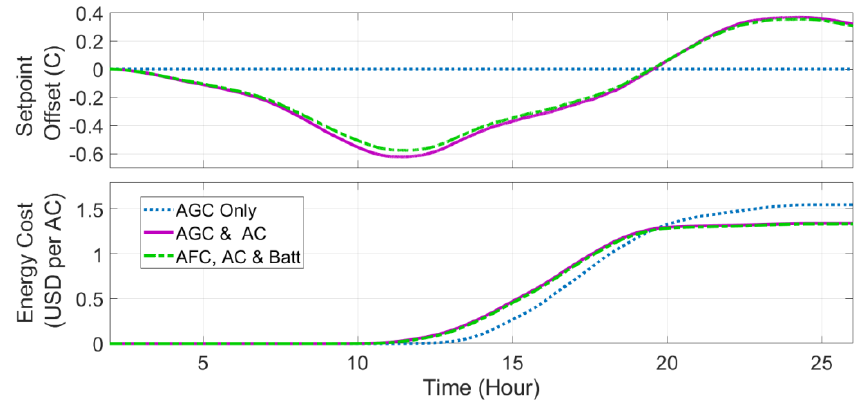
Figure 21. AC setpoint temperature offset and energy cost trajectories during the daily cycle simulation.